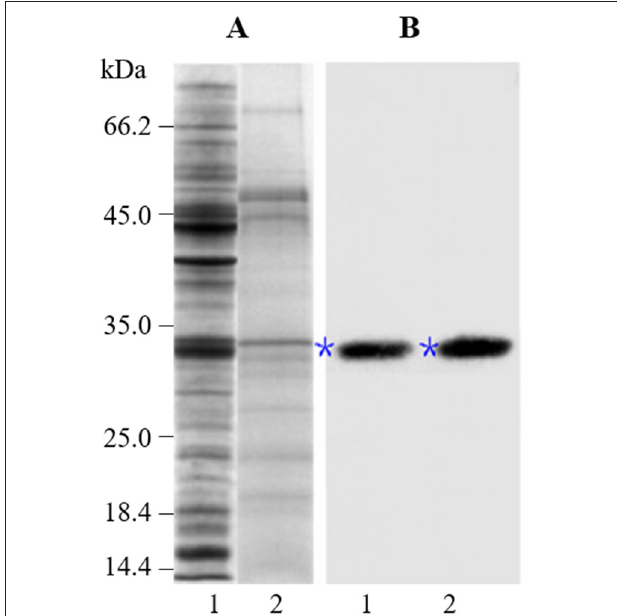
FIGURE 7 | Detection of ZmCP03 in pollen grains of maize. Proteins were separated on an equal amount of pollen fresh weight. (A) Sodium dodecyl sulfate polyacrylamide gel electrophoresis (SDS-PAGE), 12.5% resolving gel; (B) Immunoblotting, detection with anti-ZmCP03 (1: 5000 dilution). Lanes 1, pollen grains; 2, pollen coats. Asterisks indicate